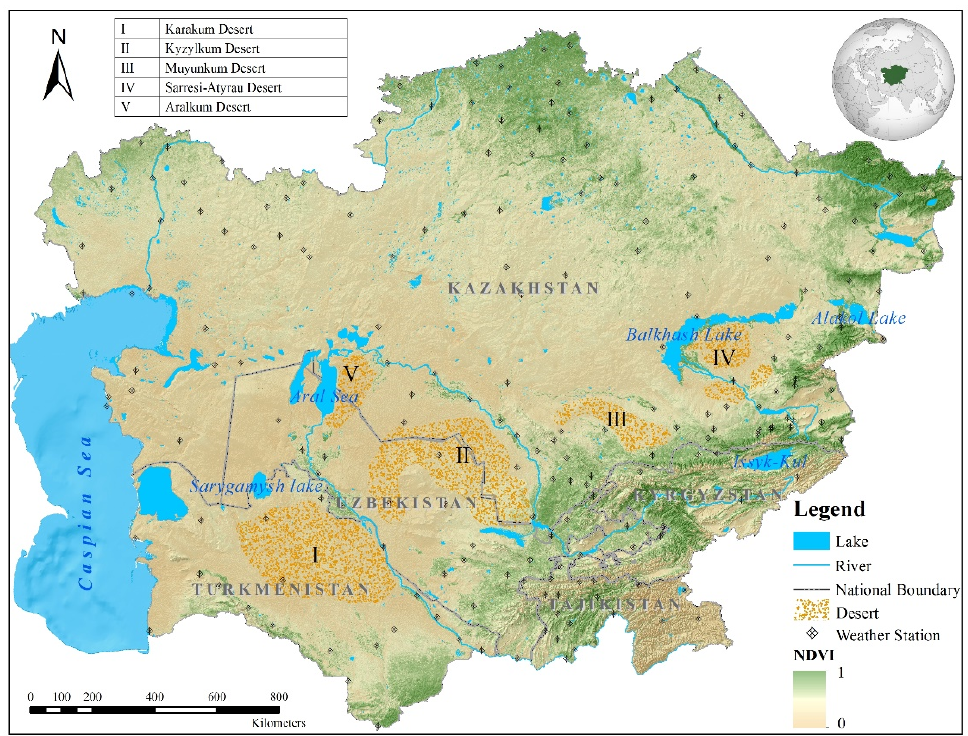
Figure 1. The study area (background image: Moderate-Resolution Imaging Spectroradiometer (MODIS) NDVI in 2019). It consists of the five former Soviet republics of Kazakhstan (KZ), Uzbekistan (UZ), Turkmenistan (TK), Kyrgyzstan (KG), and Tajikistan